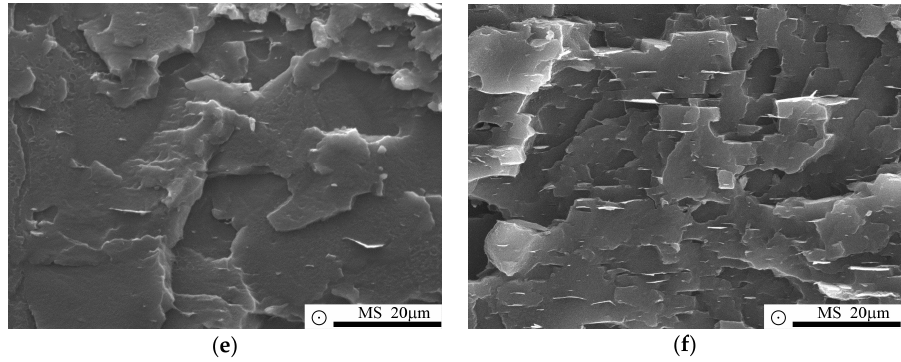
Figure 3. SEM images of LDPE powder coated with GnP nanoplatelets ( a , b ); freeze-fractured surfaces of nanocomposites filled with respectively 1% and 5% of GnP produced with a compression screw ( c , d ) and with a mixing screw ( e , f ). Extrusion direction is indicated by circles.